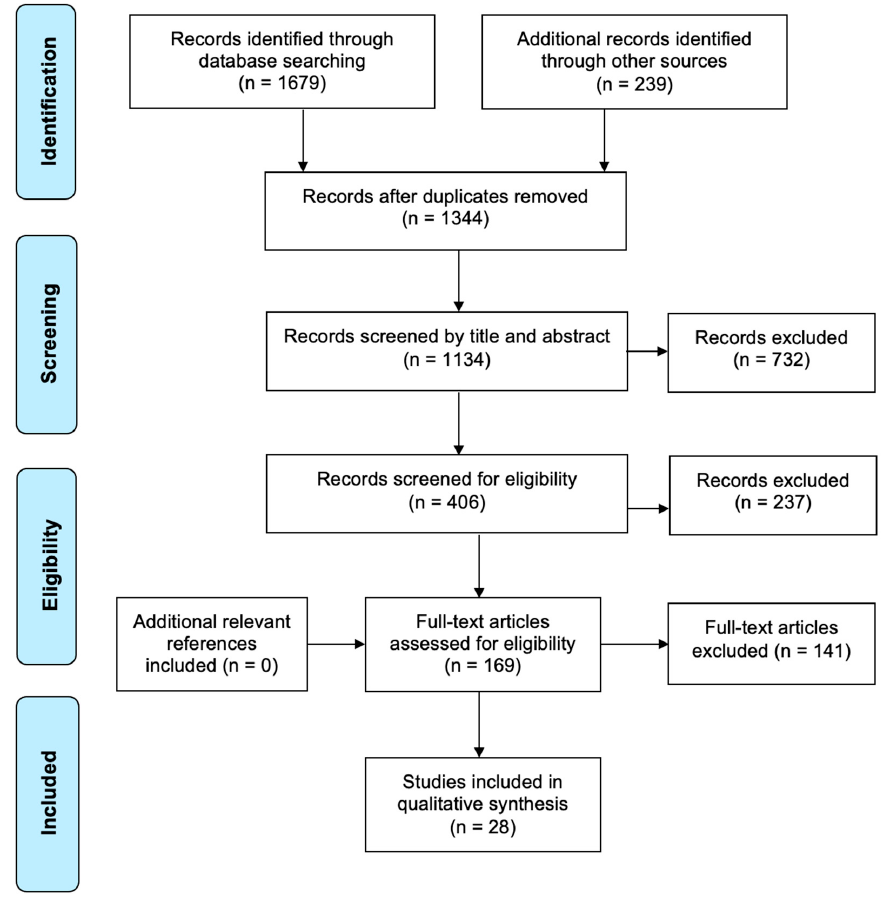
Figure 1. PRIMA Flow Diagram. Table 1. Five key strategies for developing health management workforce competency and